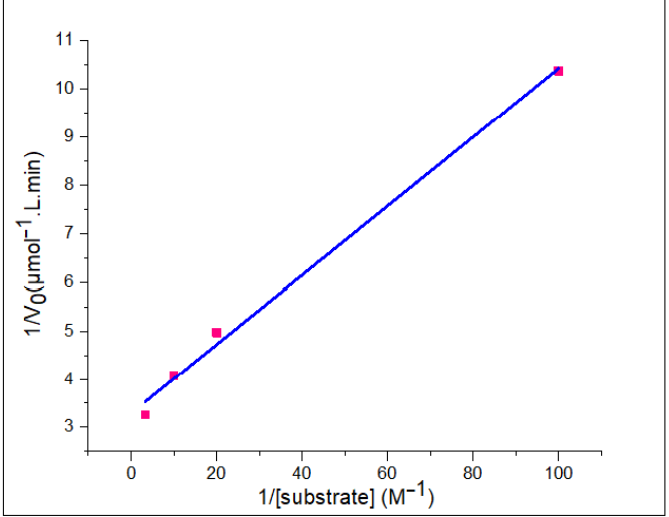
Figure 7. Lineweaver − Burk plot of 1/rate vs. 1/[catechol]. Table 4. Values of the V max and K m of the reaction catalyzed by the complex in THF. Complex